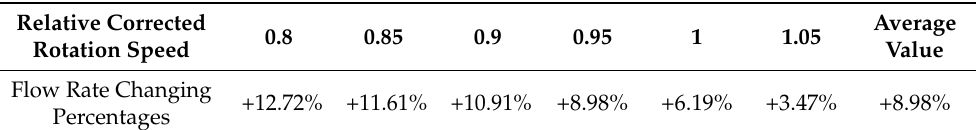
Table 5. The Flow Rate Changing Percentages of Flow Rate Adjustment with Certain AFS Surge Margin ( ∆ SM AFS >